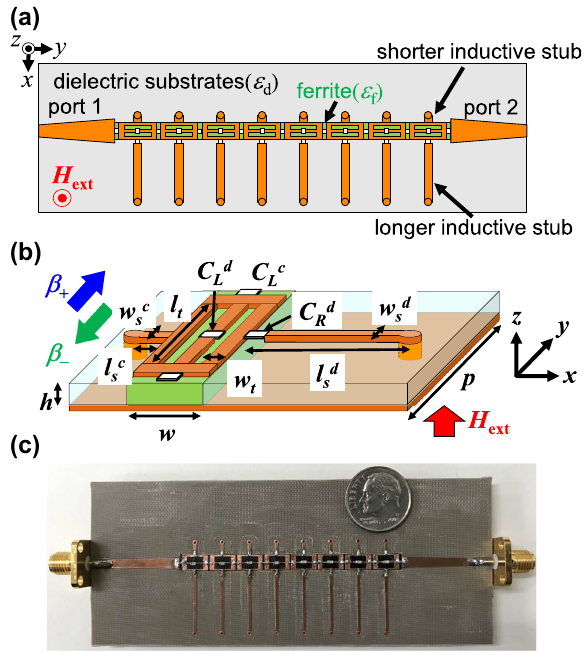
Figure 4: Schematic of the designed CRLH line and a photograph of the fabricated circuit for